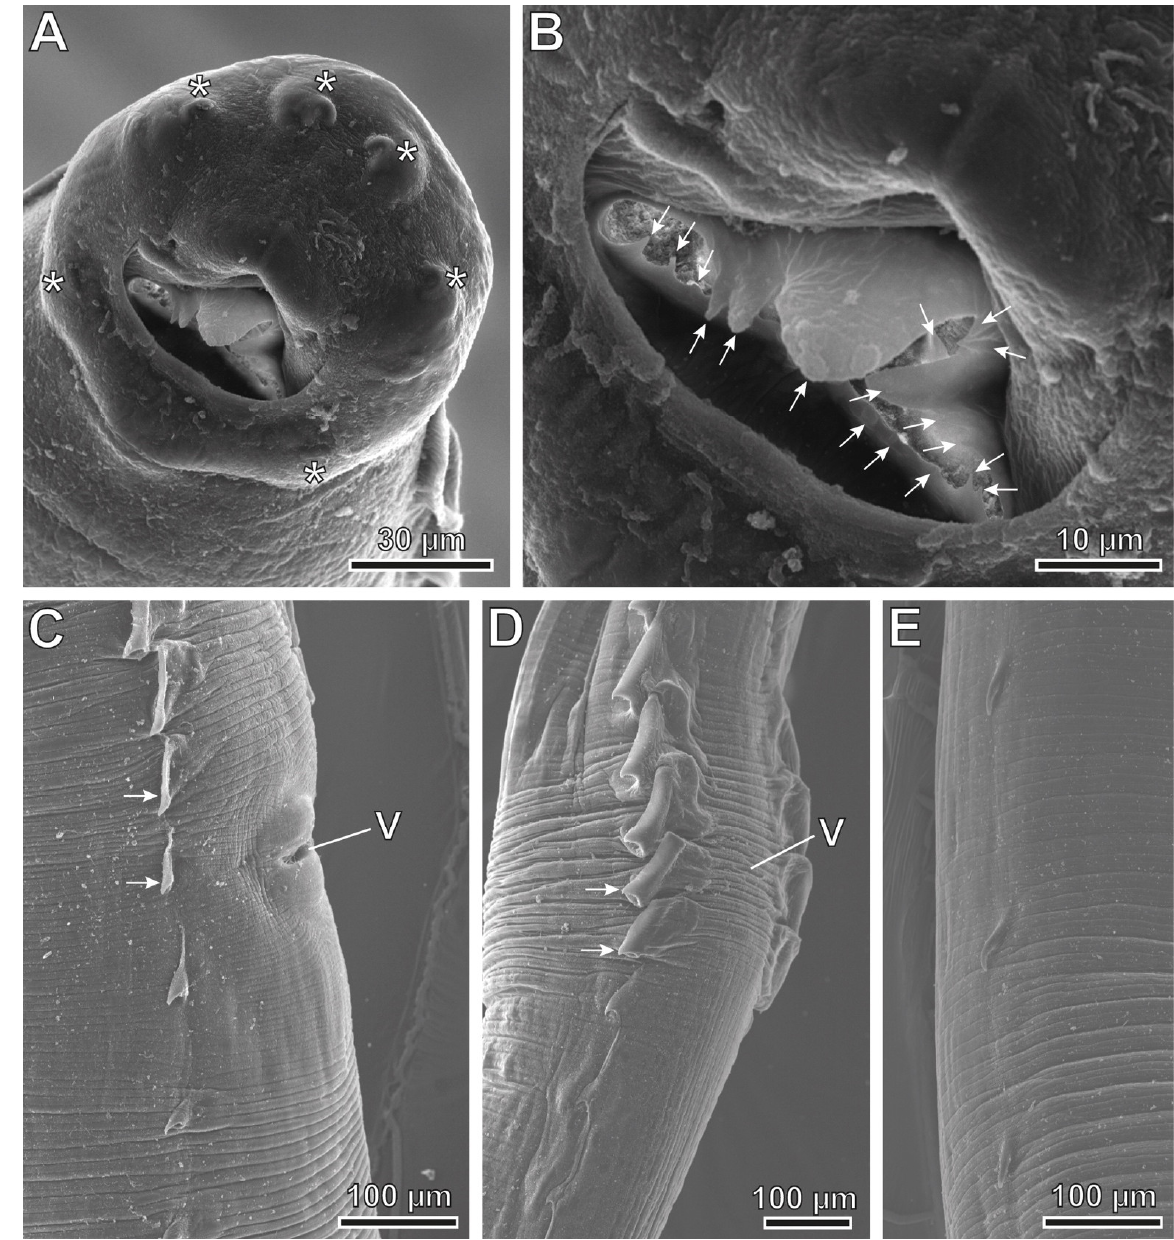
Figure 6. Pterygodermatites ( Pterygodermatites ) plagiostoma female, scanning electron microscopy. ( A ) Apical view showing the internal circle of labial papillae (*). ( B ) Detail of oral opening showing the irregular peribuccal denticles (arrows). ( C , D ) Vulvar region of two females showing the transition from combs to spines at a vulvar level or slightly posterior to the vulva (V), respectively. Note the presence of two reduced combs (arrows) before the appearance of spines. ( E ) Morphology of the most terminal spines.